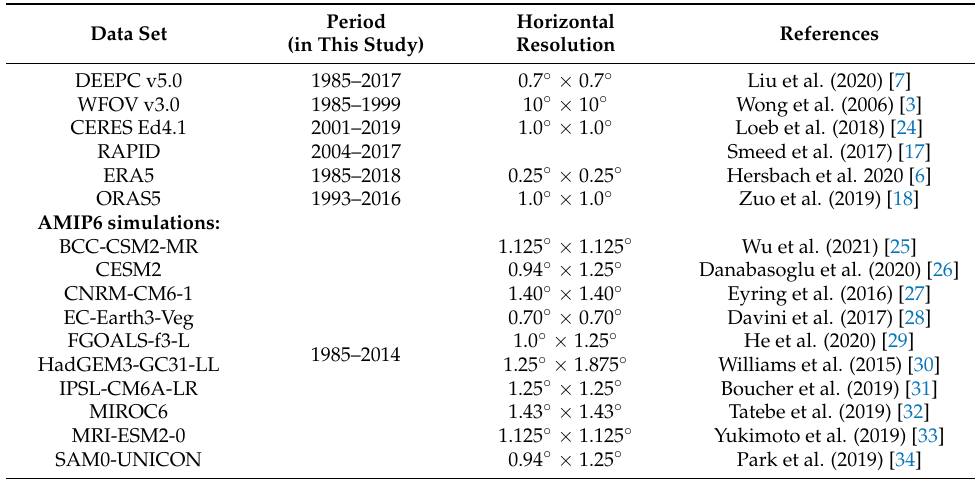
Figure 1. Flowchart of data retrieval. Table 1. Data sets and brief